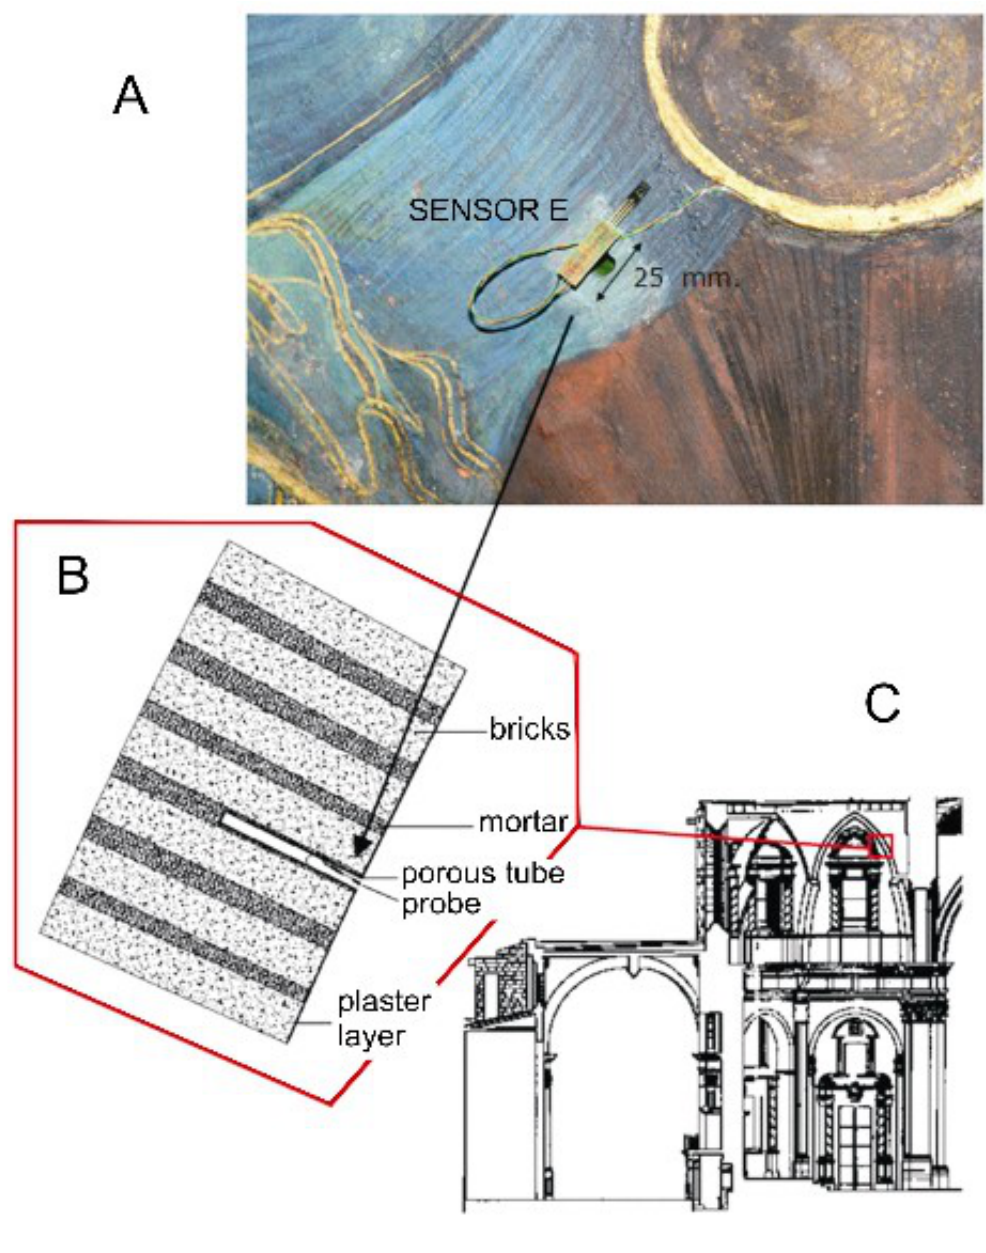
Figure 4. Installation details of probes for the microclimate monitoring of fresco paintings. ( A) picture showing Sensor E ( RH and temperature sensors assembled as indicated